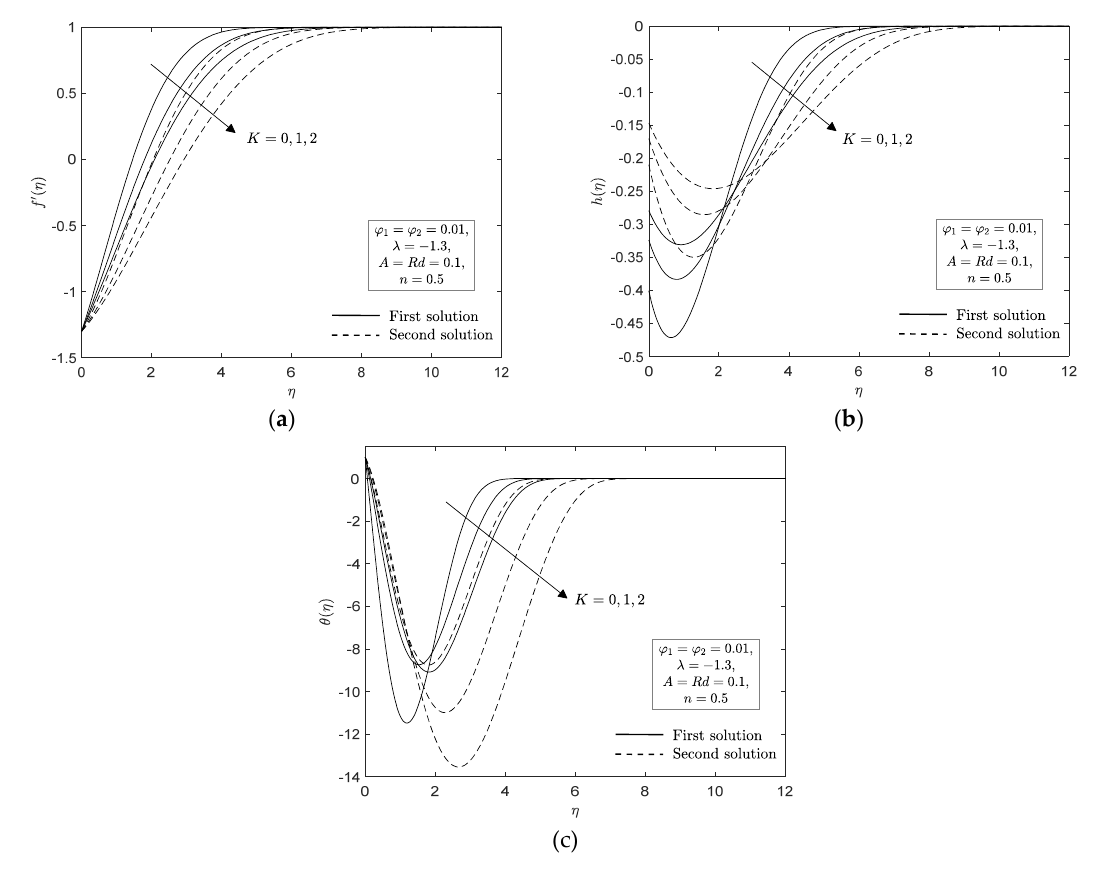
( ) f η′ ( ) h η ( ) θη Figure 7. ( a ) ; ( b ) ; ( c ) for various K Figure 7. ( a ) f (cid:48) ( η ) ; ( b ) h ( η ) ; ( c ) θ ( η ) for various K . The influence of radiation parameter Rd on the local Nusselt number Nu x Re − 1/2 Nu − The influence of radiation parameter Rd on the local Nusselt number 1/2 Re x x x ( ) θη and temperature profile are portrayed in Figure 8a,b, respectively. We have no- ticed that the radiation parameter Rd has no control on the flow field, which is evident from Equations (11)–(13). The local Nusselt number is discovered to increase with an up- surge values in radiation parameter Rd . Furthermore, the thermal boundary layer thick- ness become thicker when this parameter raises in the first solution and it became slimmer in the second solution. As can be seen from Figure 8b, this parameter however does not give effect on the range of similarity solutions to occur, i.e., the critical value for stretch- λ is the same for all values of radiation parameter Rd . It is ing/shrinking parameter c noteworthy that the distribution of temperature in the fluid is significantly affected by the radiation parameter Rd . Physically, this is due to the fact that the heat is produced due to the radiation process and therefore, enhances the fluid temperature.